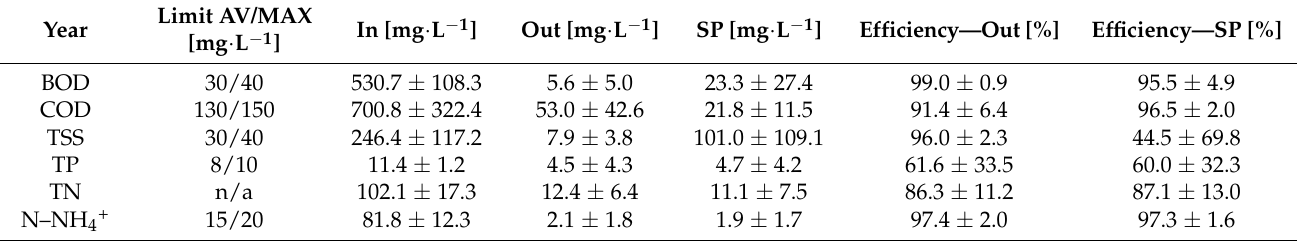
Table 4. Summarized operation performance of HCW during full